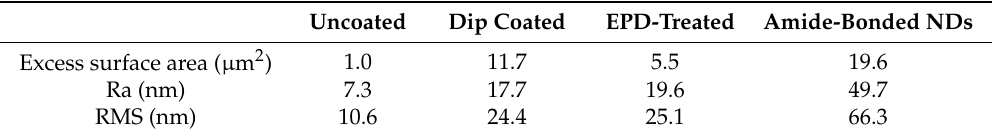
Table 1. Excess surface area, mean deviation (Ra), and the root mean square (RMS) of surface roughness parameters for the uncoated, dip-coated, EPD-treated, and amide-bonded NDs on Ti. Projected area = 400 µ m 2 . Uncoated Dip Coated EPD-Treated